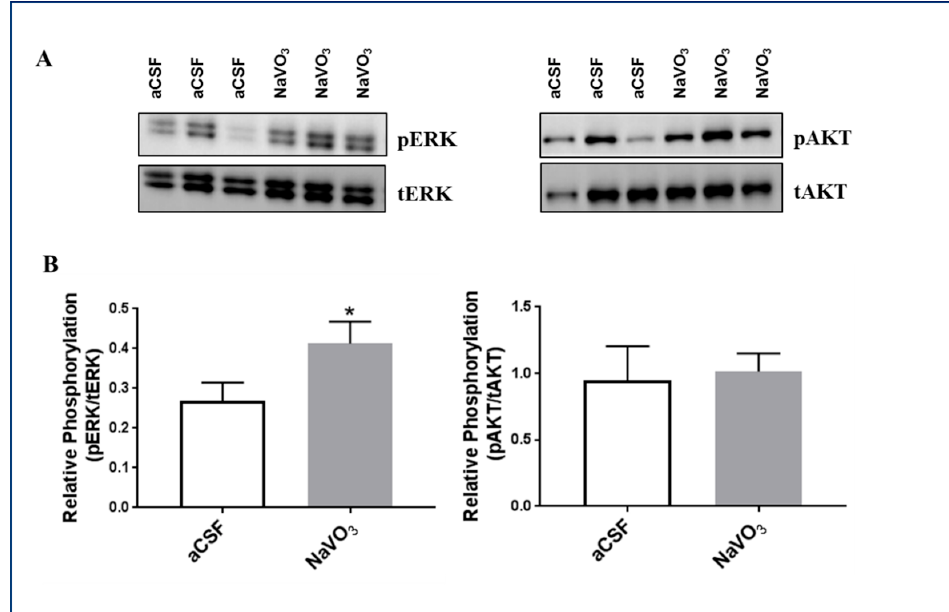
Figure 6. Effect of NaVO 3 administration on brain ERK and AKT phosphorylation. Mice were treated with NaVO 3 (3 μ L from a 10 mM stock in CSF) and their behavior was examined as described in the legend to Figures 3 and 4. Following the behavioral tests (Figure 4) the mice were euthanized. The brains were dissected and the proteins were extracted. ERK and AKT phosphorylation was determined by western blot analysis, as described in Materials and Methods. ( A ): Representative western blots. ( B ): Quantitative ERK and AKT relative phosphorylation. The values were normalized to the levels of Total ERK and AKT levels. The values are expressed as the mean ± SEM ( n = 4). * significantly different from mice treated with aCSF, p < 0.05.